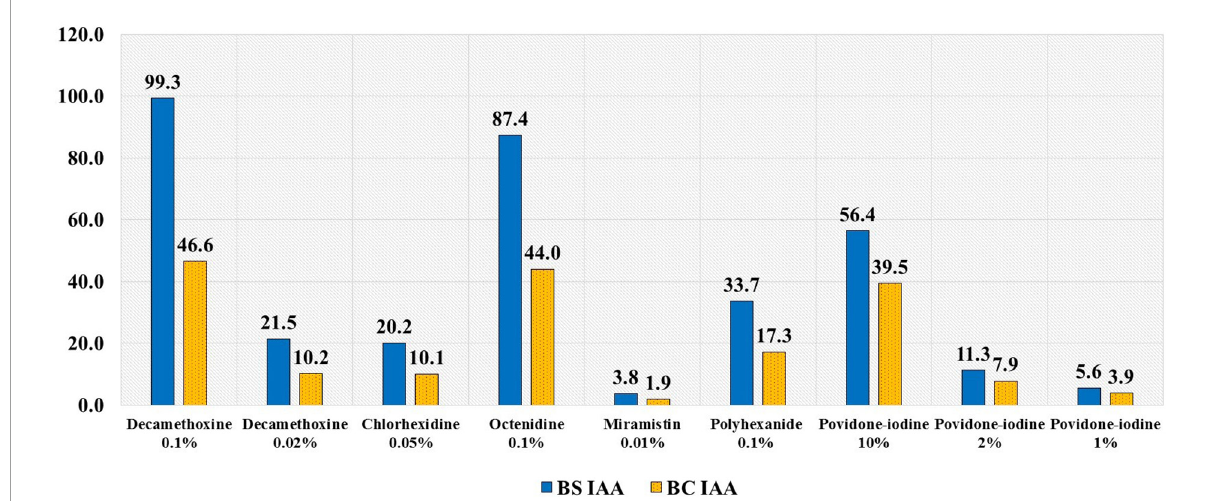
FIGURE1 The average values of bacteriostatic (BS) and bactericidal (BC) IAA in relation to clinical isolates of A. baumannii.